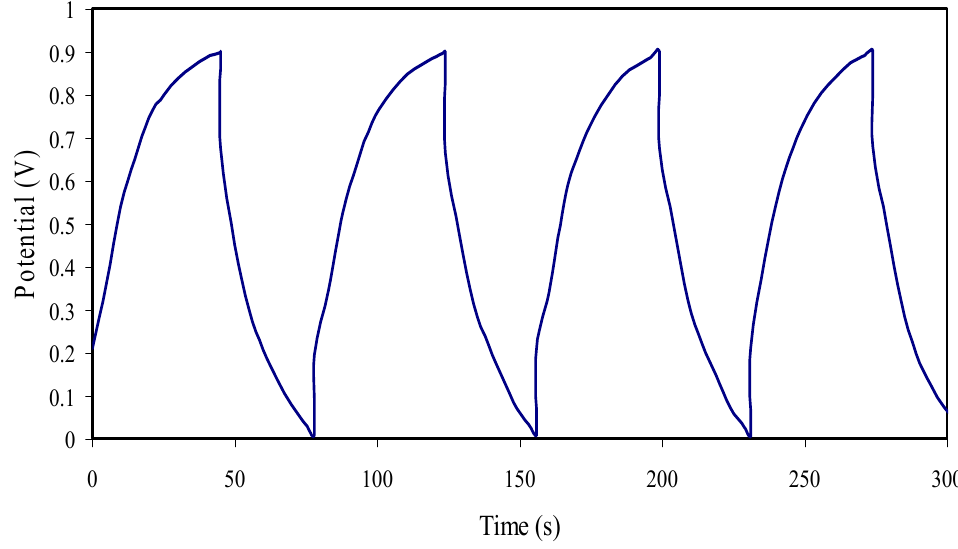
Figure 12. Galvanostatic charge-discharge performances of the constructed EDLC for the initial cycles.